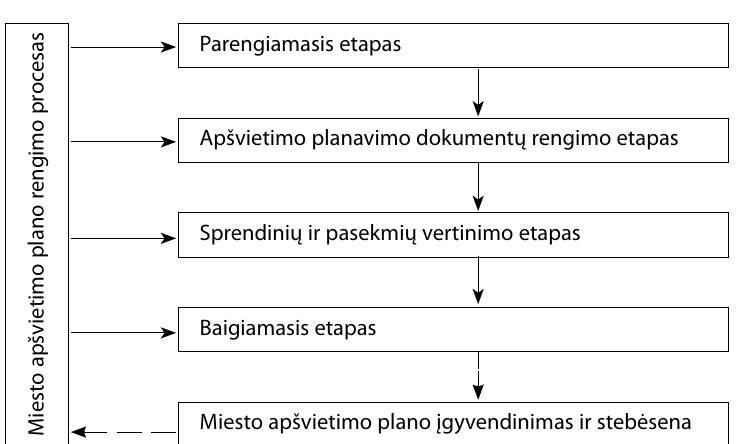
Fig. 1. Scheme of preparing urban lighting